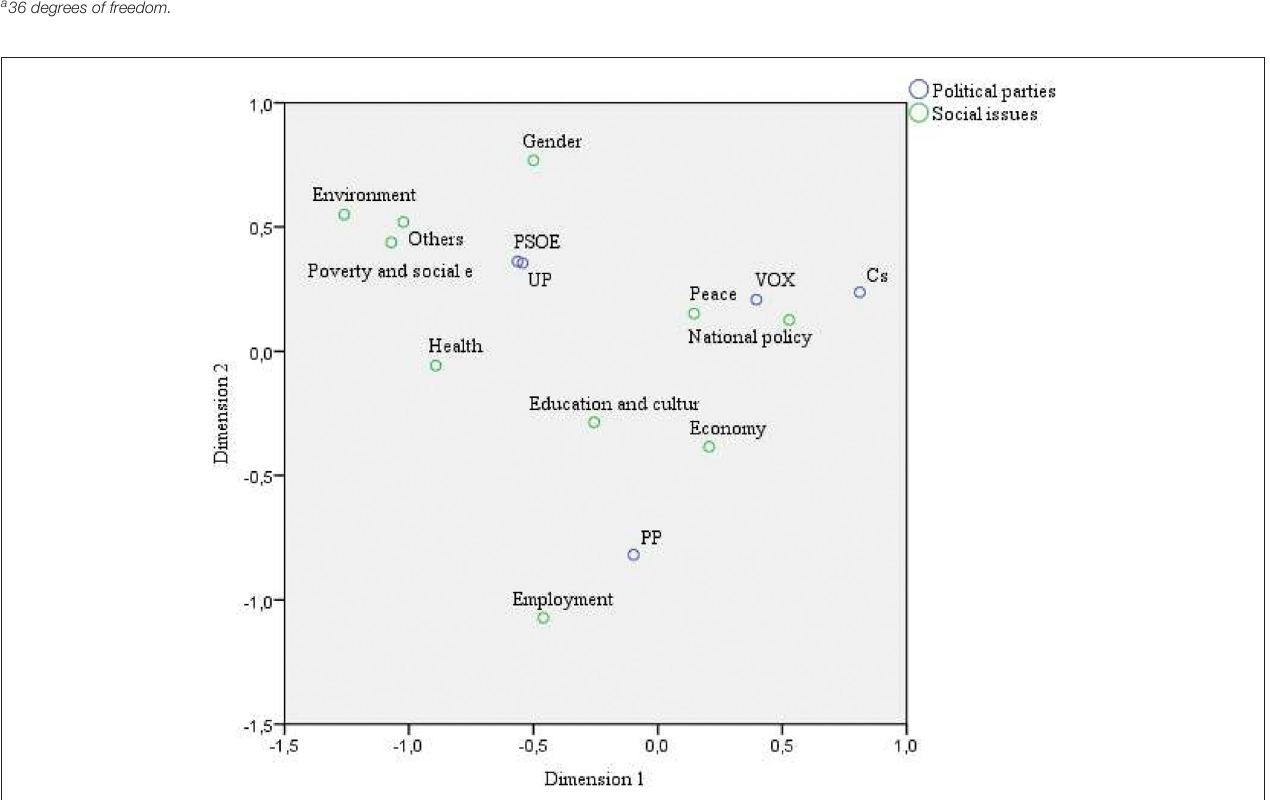
FIGURE 4 | SCA Perceptual Map. Source: Own elaboration.